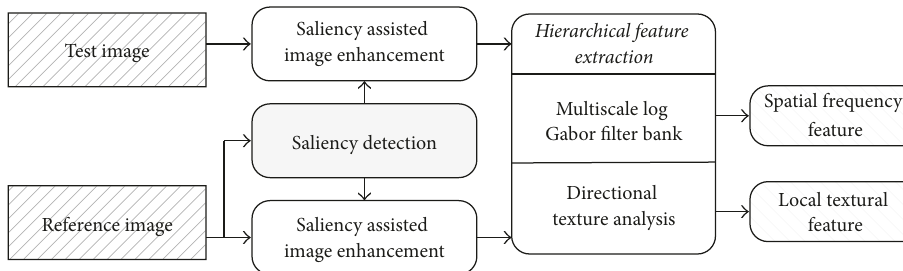
Figure 2: Framework of the saliency-assisted hierarchical feature